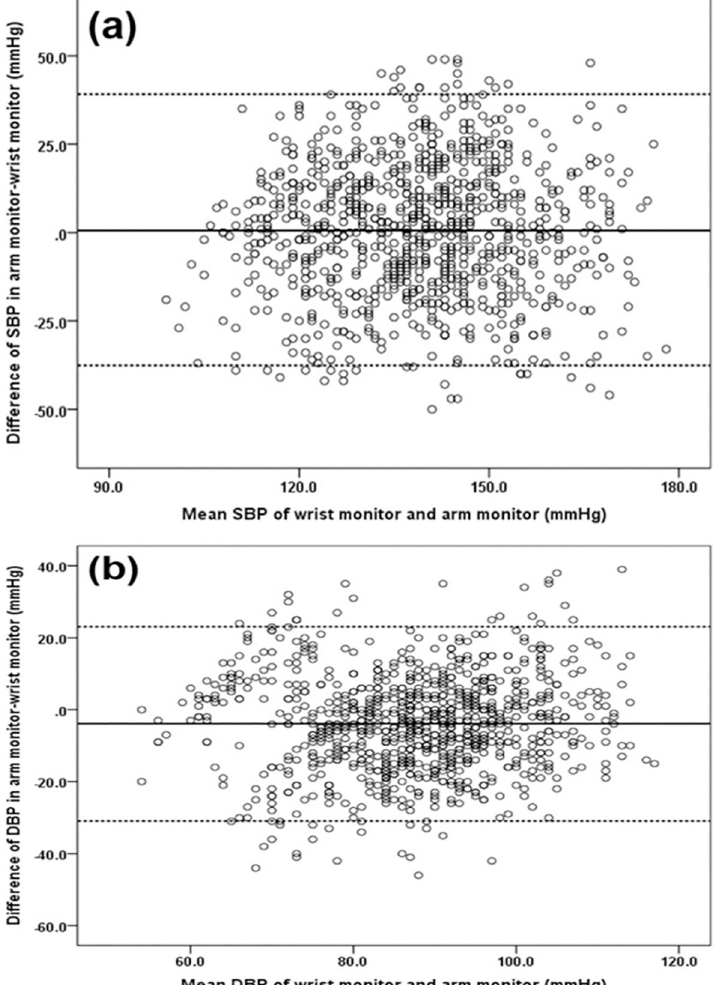
Fig 1. Bland–Altman plots presenting the mean and the difference in blood pressure measurements (mmHg) between the wrist and arm monitors over 24 hours for SBP (a) and DBP (b). The solid black horizontal line represents the mean difference and the dotted horizontal lines represent 2SD above and below the mean. There was a mean difference of +0.7 mmHg and a 2SD difference between the arm monitor and the wrist monitor of -37.7 to 39.1 mmHg for SBP and a mean difference of -3.9 mmHg and a 2SD difference of -30.9 to 23.1 mmHg for DBP. DBP = diastolic blood pressure, SBP = systolic blood